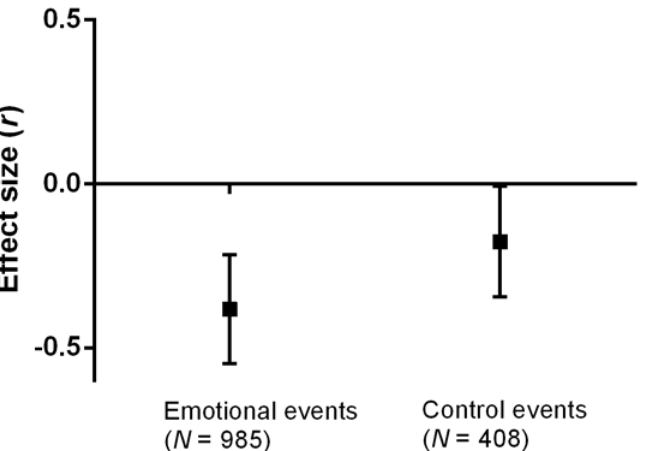
Fig 3. Meta-analysis of the effect of rumination on reduced temporal distance from Studies 1 through 3. Values represent the mean effect sizes and 95% confidence intervals (i.e., the mean ± 1.96 SEMs). The effect size was significantly different and more than twice as large for rumination about emotional events compared to thinking about control events.